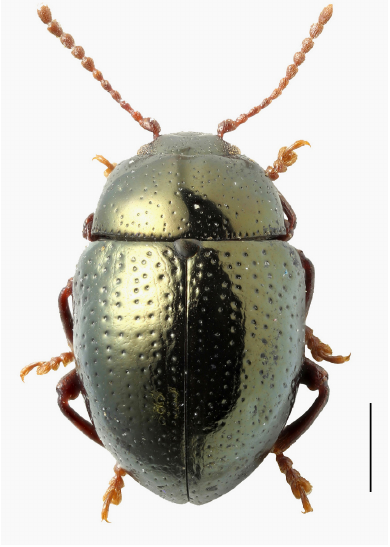
Figure 10. Sclerophaedon carpathicus Weise, 1875, male (Ukraine, Transcarpathia, Marmarosh Massif)—habitus in dorsal view. Scale bar—1 mm.